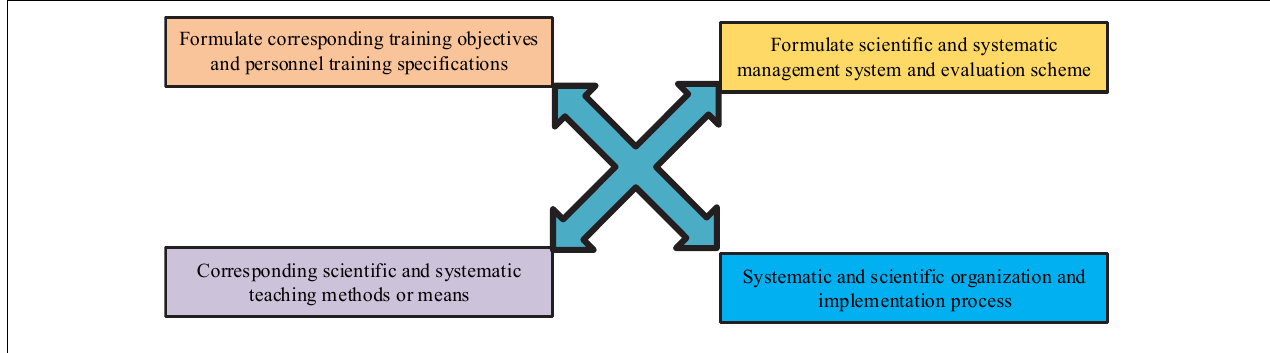
FIGURE 2 | Talent training model module.